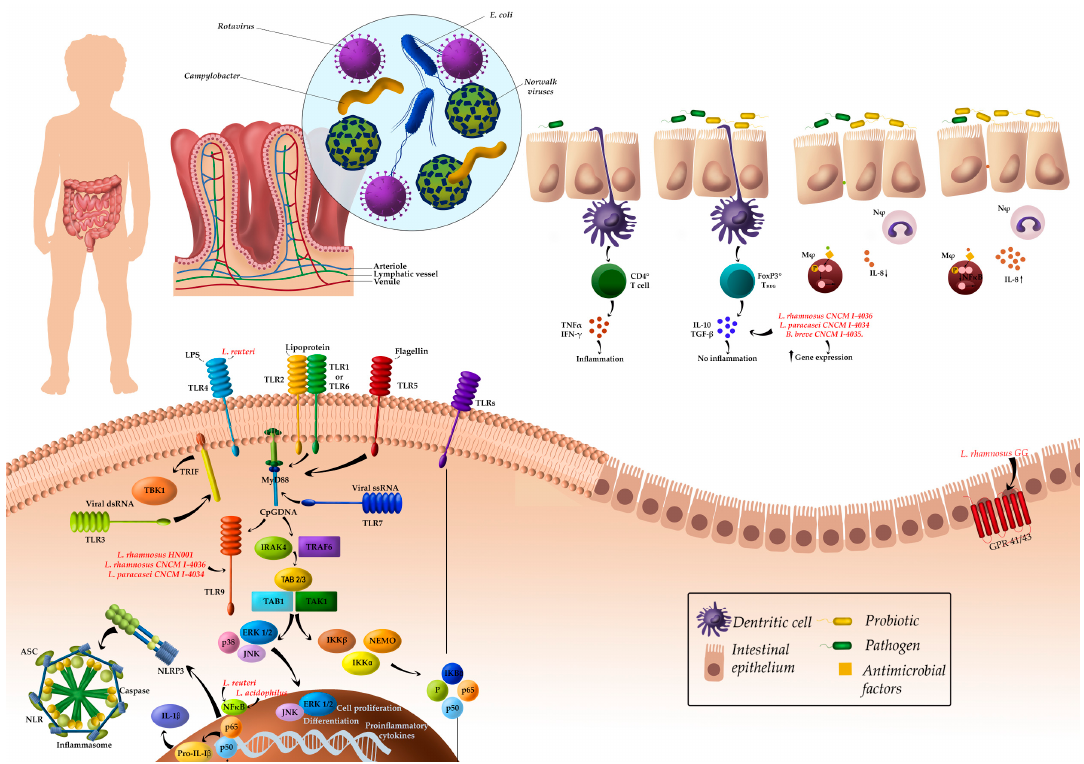
Figure 1. General probiotic mechanism of action in pediatric gastrointestinal infections. Abbreviations: ASC, apoptosis-associated speck-like protein containing a CARD; ERK, extracellular regulated kinase; IKK, I κ B kinase; IL, interleukin; IFN, interferon; IRAK4, IL-1 receptor-associated kinase 4; JNK, Jun N-terminal kinase; NF- κ B, nuclear factor κ -B; NEMO, NF- κ B essential modulator; TNF- α , tumor factor necrosis alpha; TLR, toll-like receptor, TAB1/2/3, TAK binding proteins; TAK1, ubiquitin-dependent kinase of MKK and IKK; TBK1, serine/threonine-protein kinase 1; TGF, transforming growth factor; TRAF6, Tumor necrosis factor receptor-associated factor 6.